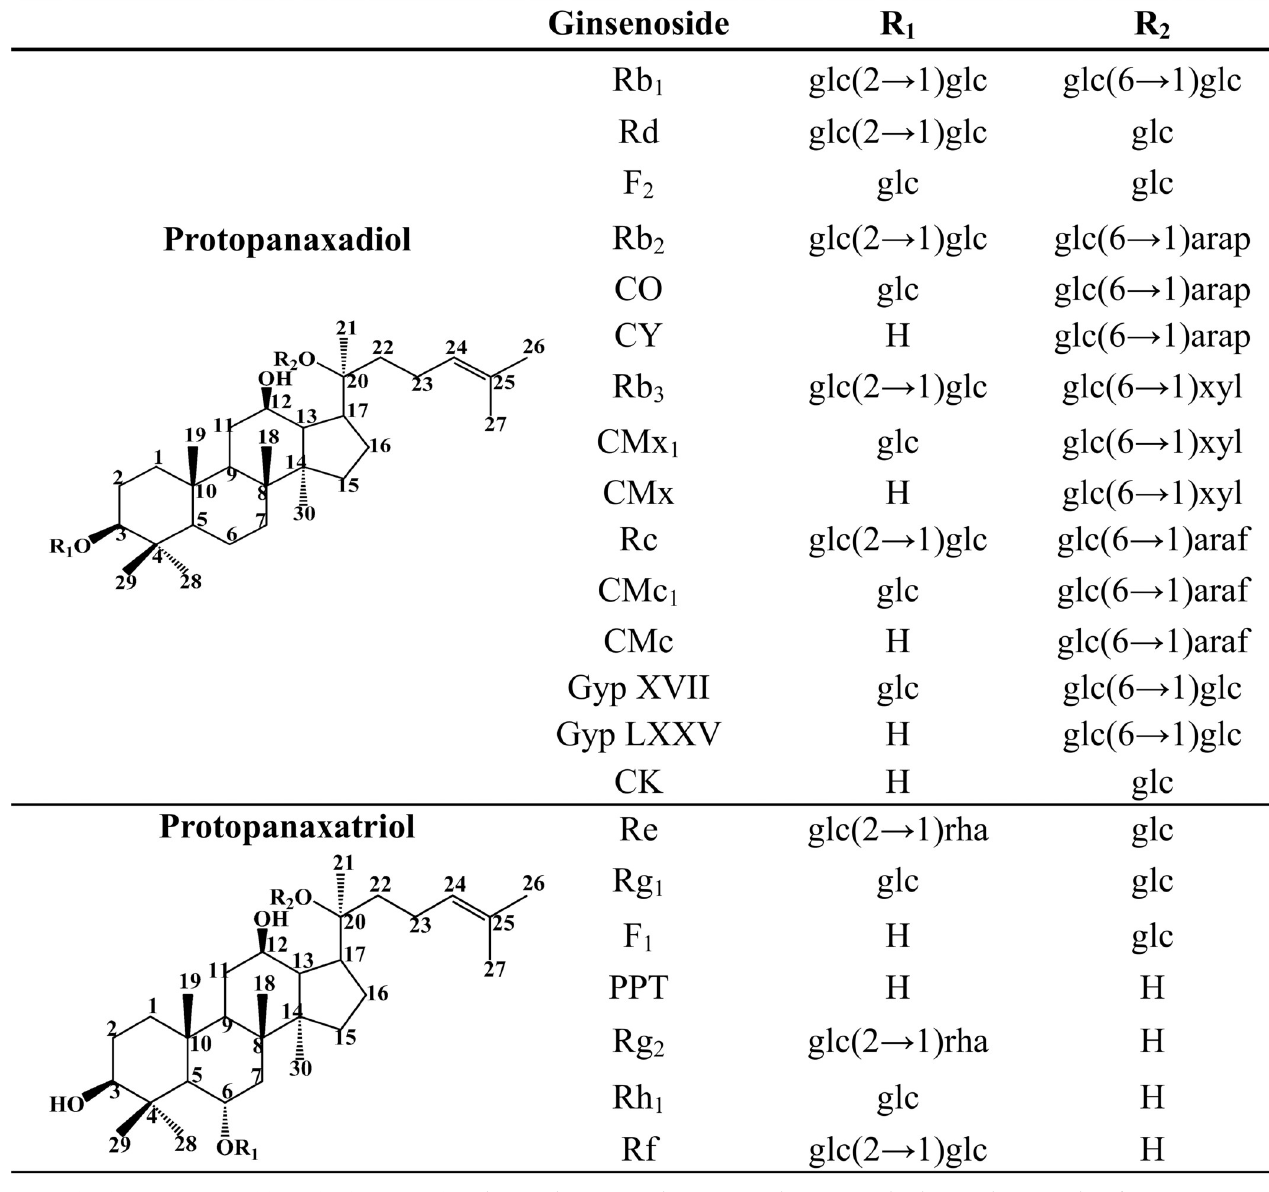
PLOS ONE | https://doi.org/10.1371/journal.pone.0255899 August 6,